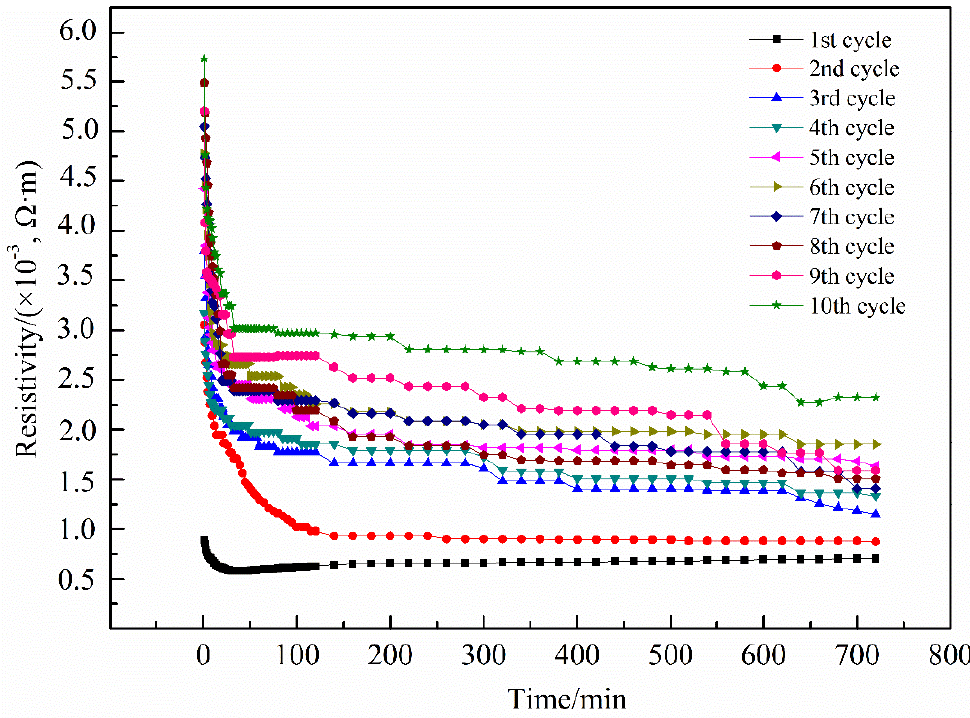
Figure 13. Resistivity–time curves of the cyclic electrification test of heat-treated coatings.